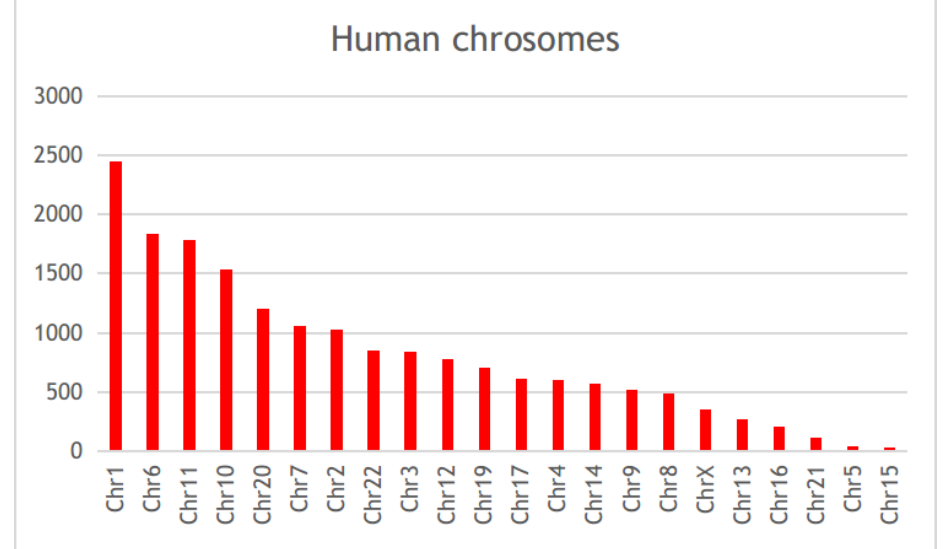
Figure 3. The chromosomal distribution of the diabetes-associated genes in published